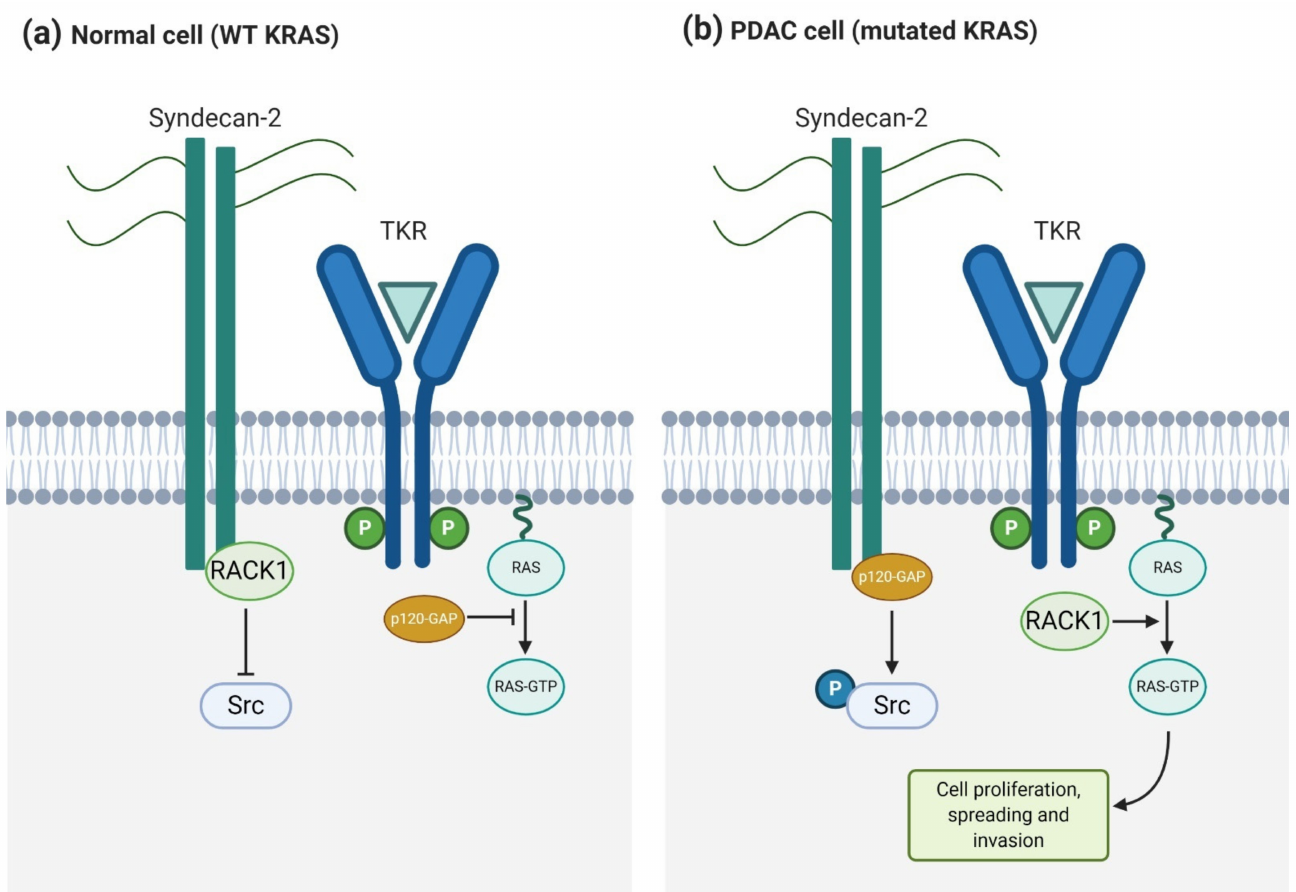
Figure 4. Syndecan-2 and KRas cooperate to induce an invasive phenotype in pancreatic cancer cells. ( a ) In normal cells, RACK1 binding to syndecan-2 prevents Src activation and free p120-GAP inhibits Ras signaling triggered by TKRs ( b ) In pancreatic ductal adenocarcinoma (PDAC) cells, p120-GAP binding to syndecan-2 activates Src and free RACK1 enhances TKR-mediated Ras activation, promoting cell proliferation, spreading, and